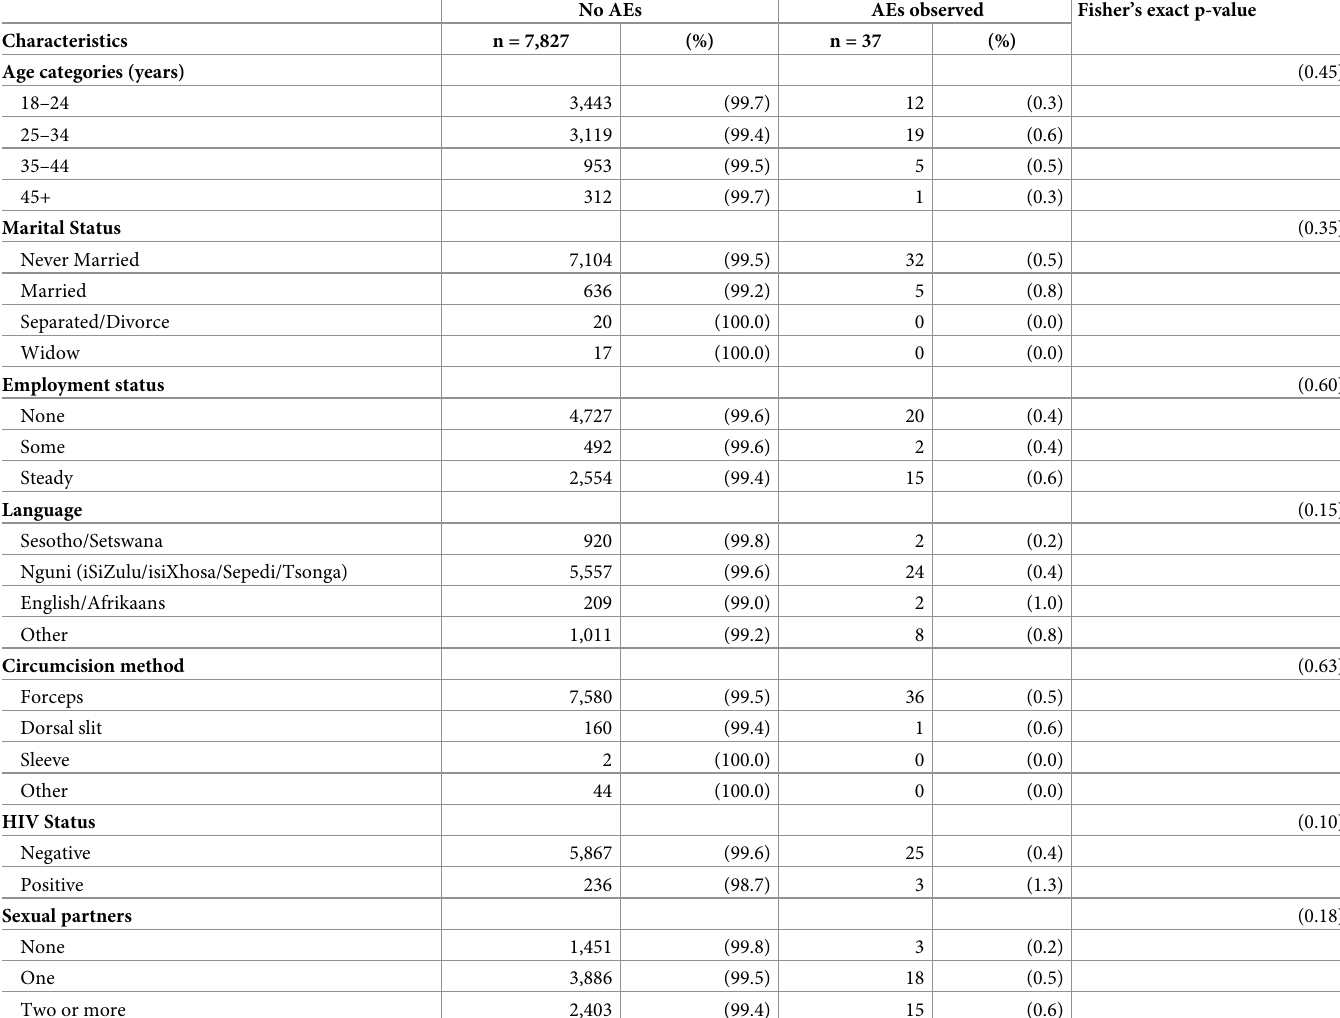
Table 3. Bivariate associations between adverse events (AEs) and socio-demographic characteristics (n = 7,864) of adult men in Gauteng and North West provinces of South Africa (01-May-2013 and